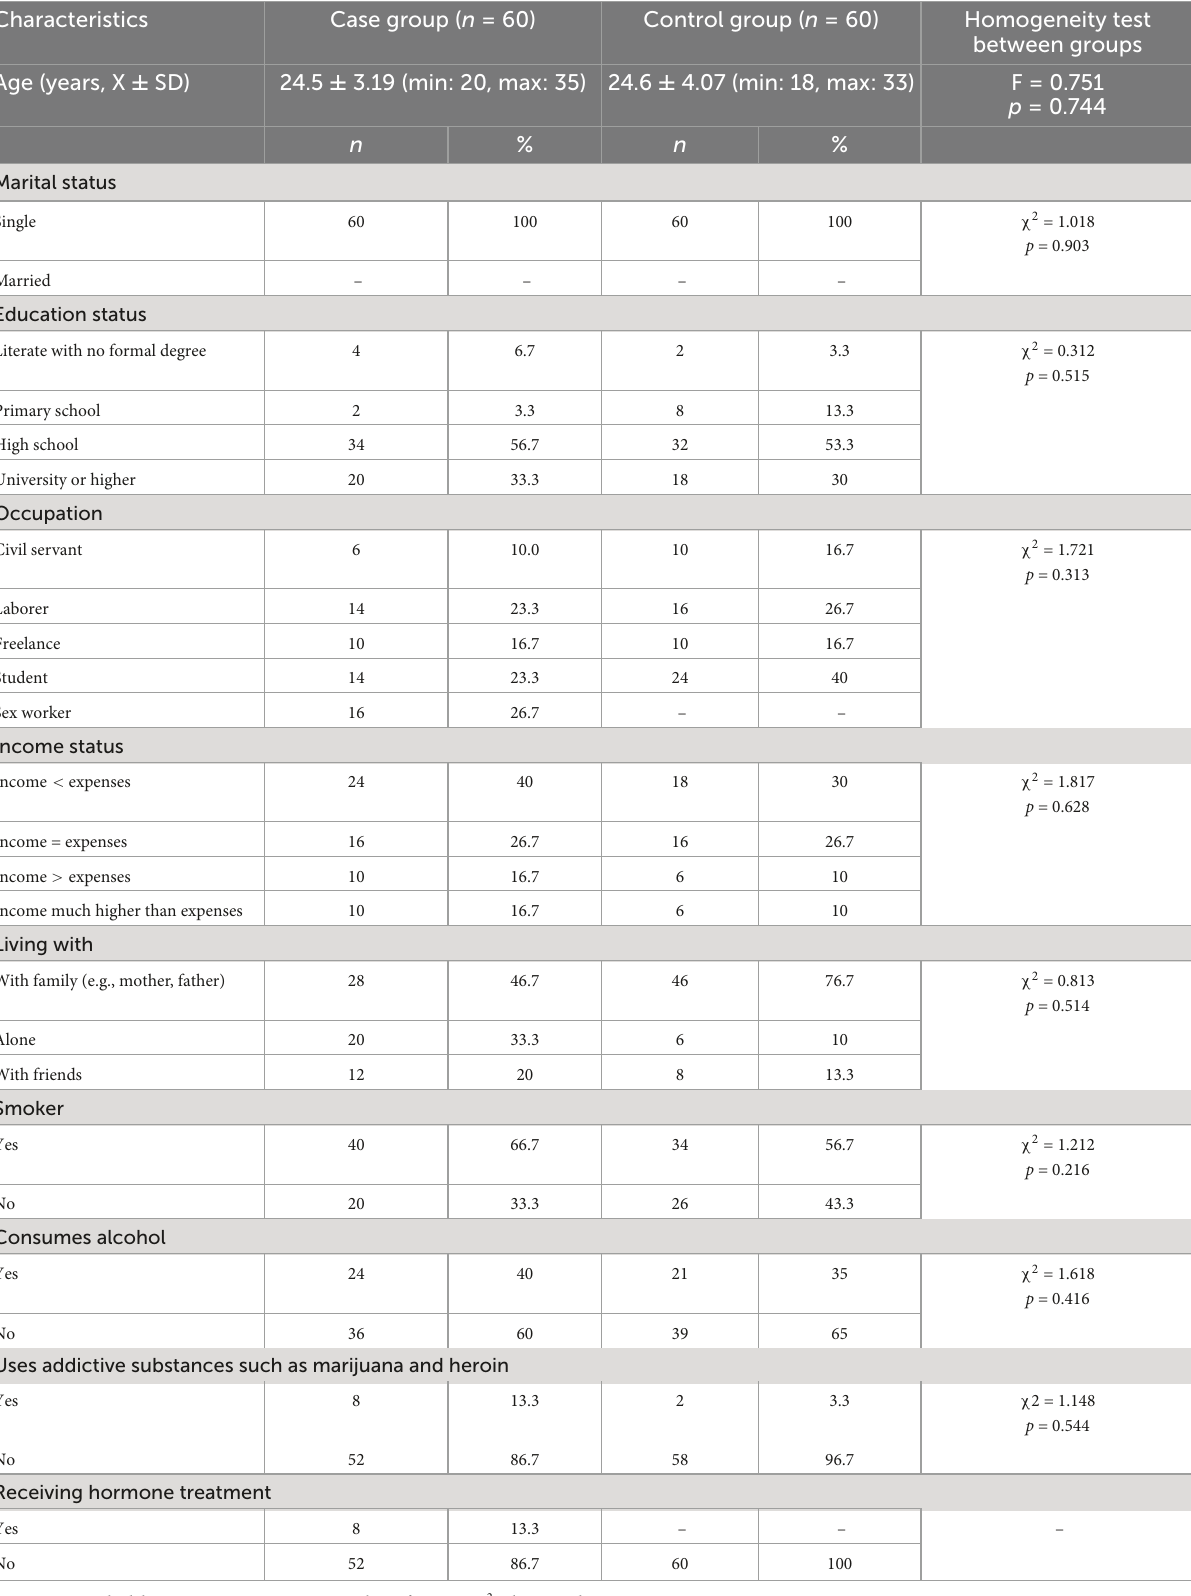
TABLE 1 Descriptive characteristics of case and control groups and homogeneity test results ( n =